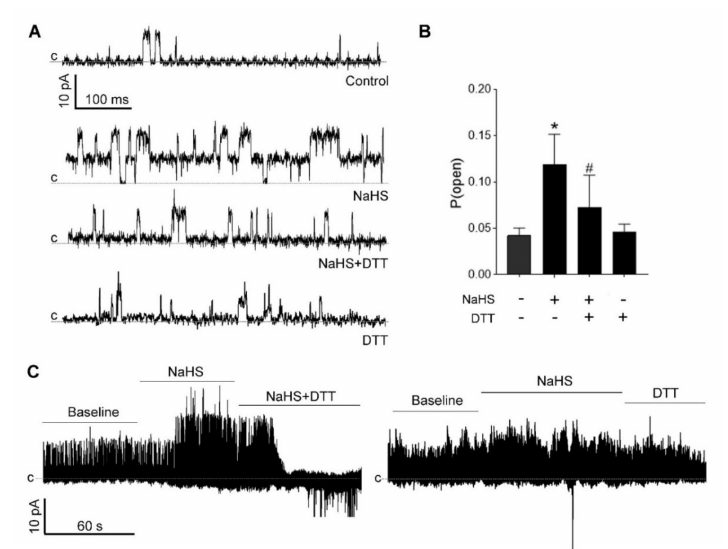
Figure 5. The BK Ca channel opening activity of H 2 S was redox-sensitive. ( A ) Original outside-out single-channel currents with dithiothreitol (DTT, 1 mM) in the pipette solution before and during NaHS (100 µ M) application. Holding potentials were + 60 mV with 0.1 µ M free Ca 2 + in the pipette solution. ( B ) Open probability ( P open) of BK Ca was significantly increased from 0.036 ± 0.011 ( n = 7) in the control group to 0.119 ± 0.032 ( n = 7) by 100 µ M NaHS; the addition of DTT decreased the H 2 S-induced P open to 0.072 ± 0.034 ( n = 6). * p < 0.05 compared with control group; # p < 0.05 compared with NaHS group. P open was 0.046 ± 0.008 ( n = 4) in the presence of DTT alone. ( C ) DTT on NaHS (100 µ M) stimulated outside-out single-channel currents. Co-incubation with DTT (1 mM) blocked the outward currents (left), while DTT alone did not alter baseline outward current (right). Currents represent similar experiments from di ff erent cells. c: indicates the close state of channels.